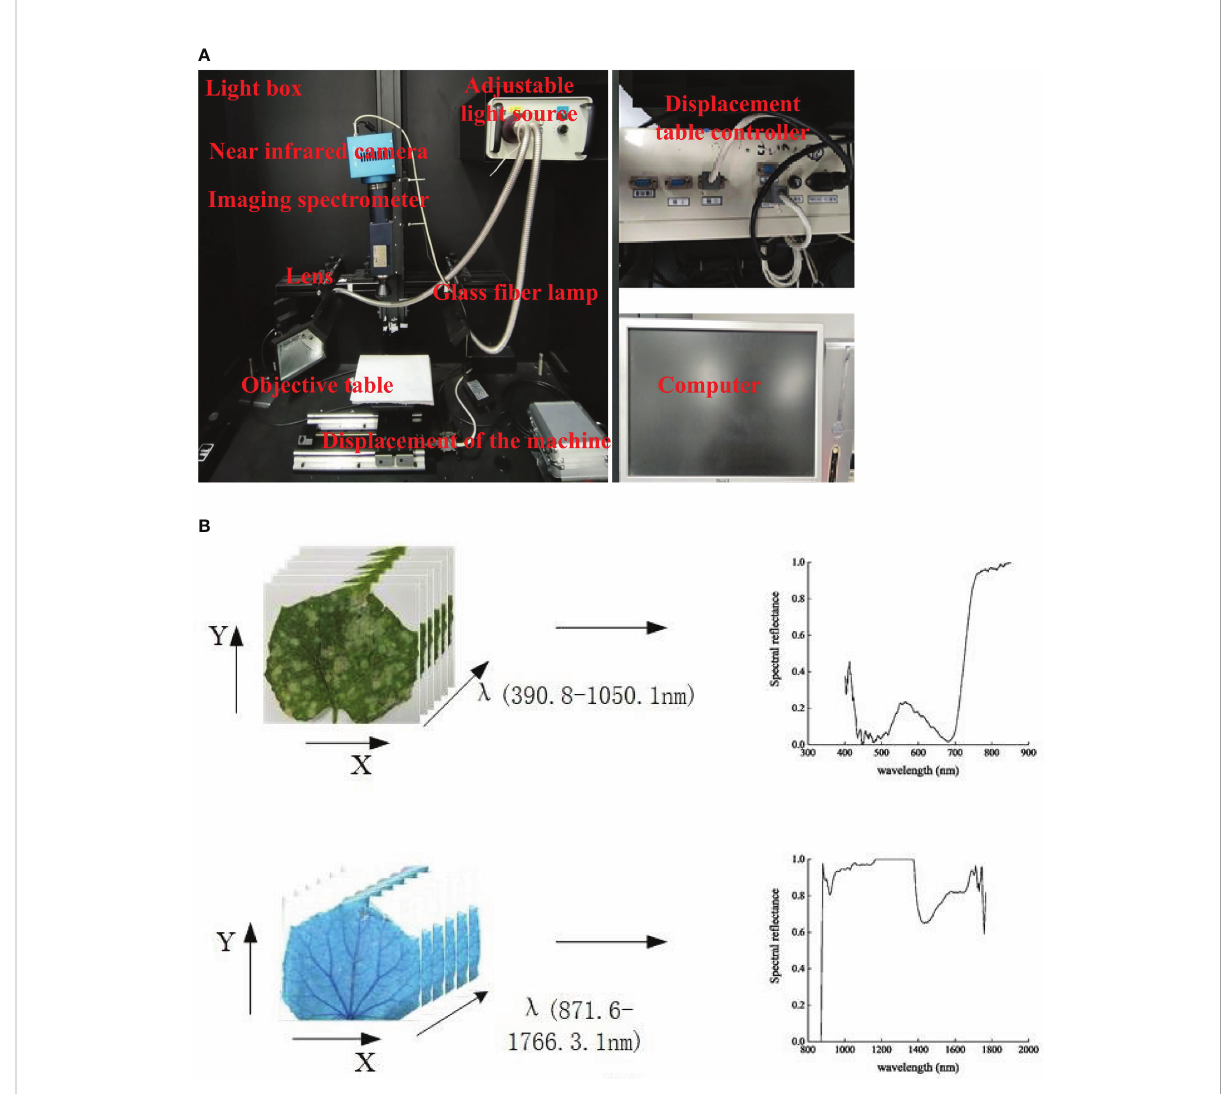
FIGURE 1 Hyperspectral imaging system. (A) Visible-near infrared hyperspectral equipment. (B) Visible-near infrared hyperspectral data